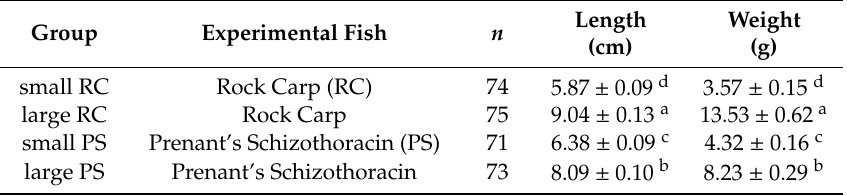
Table 1. Length and weight of experimental fish. Values are expressed as the mean ±